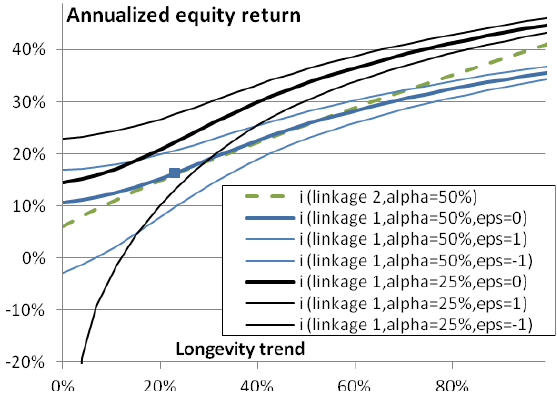
Figure 4. Annualized equity return, 𝑖 , as a function of longevity trend φ . This graph is similar as Figure 3 except that (black) curves are superimposed to should annualized equity returns: the annualized returns of investing in the equity part of the fund, rather than the whole megafund annualized return.